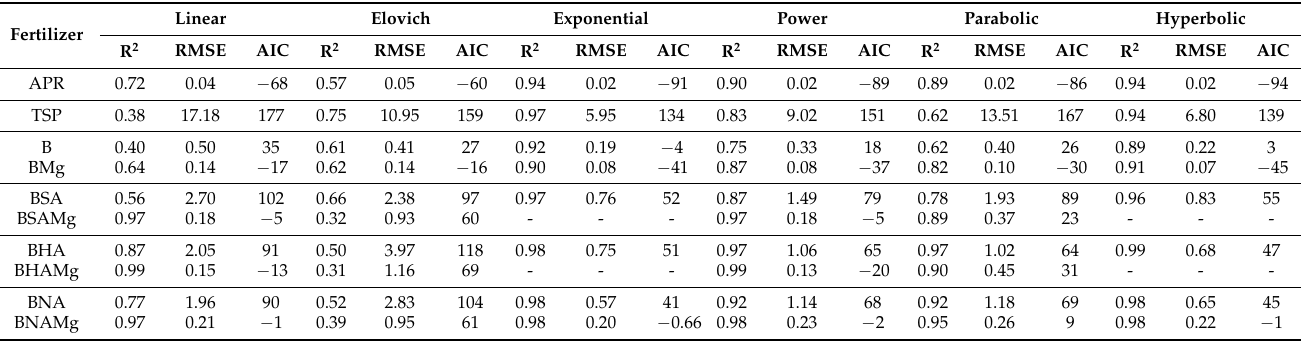
Table A3. Coefficients of the kinetics of P release in water for each fertilizers studied.